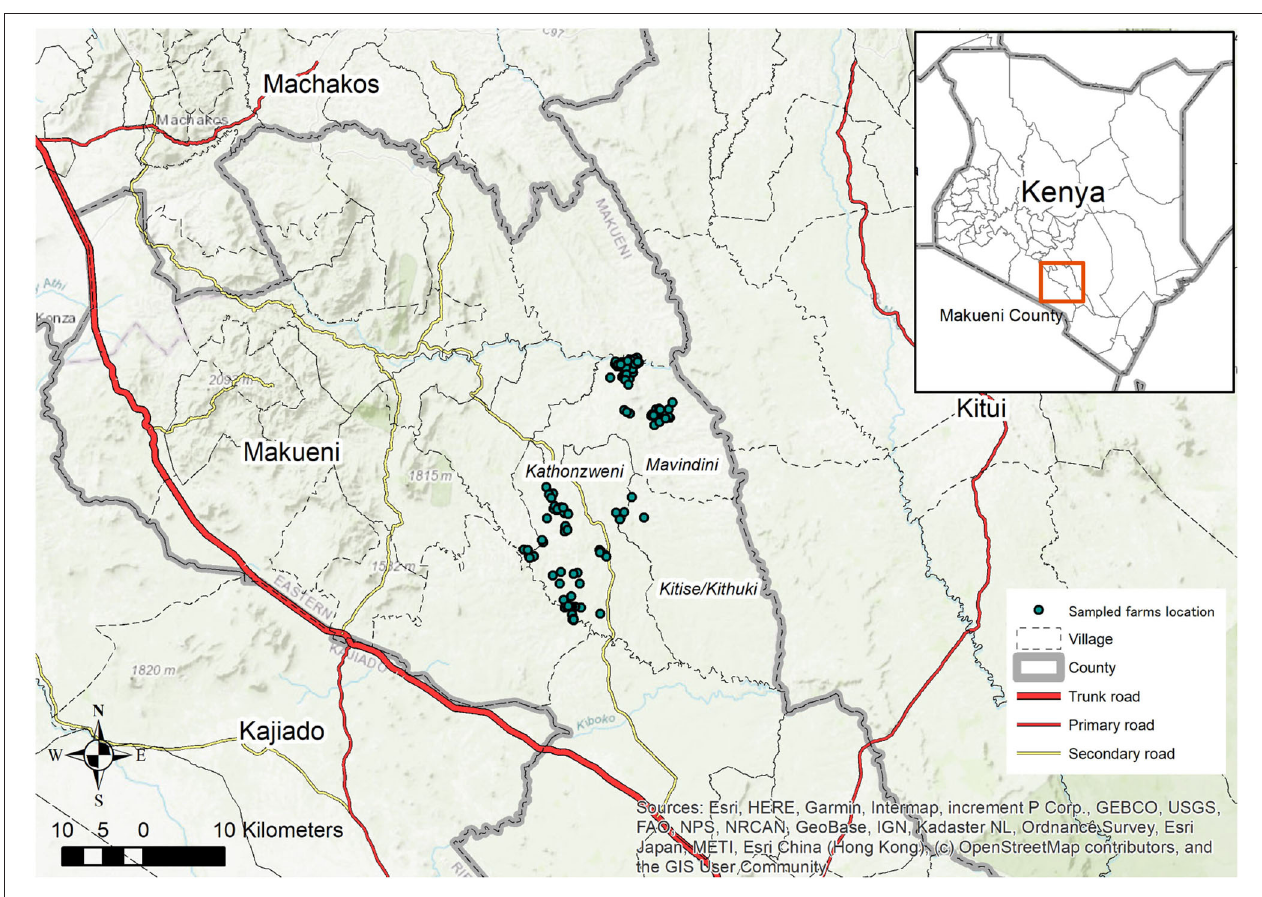
FIGURE 2 | Location of study area in South-East